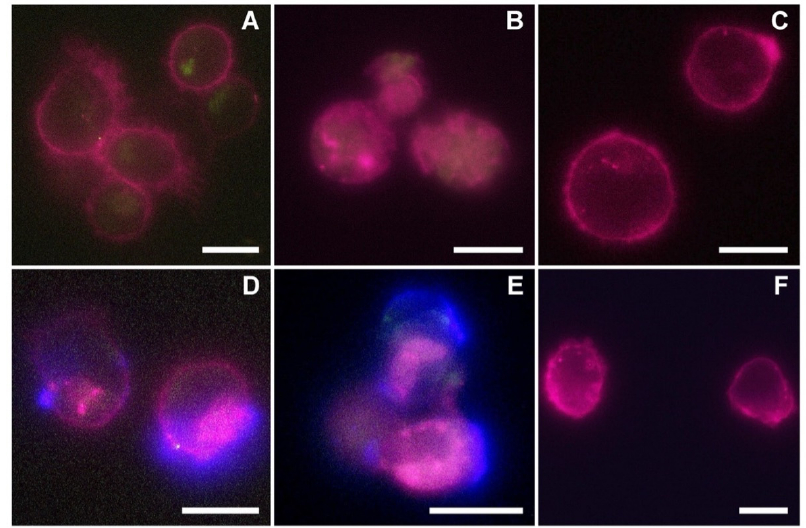
Figure 9. Representative fluorescence microscopy images of the three cell lines incubated for 48 h with 5 µg/mL of native (top panels) and anti-CD20 engineered lymphocyte-derived EVs (bottom panels). Panels A and D refer to lymphocytes, B and E to Daudi, and C and F to HL60 cell lines incubated with nEVs ( A – C ) and EVsCD20 ( D – F ). The purple color represents the cells’ membrane labeled with WGA647, green refers to the EVs labeled in WGA488, while the blue channel refers to the AMCA fluorescent signal of the secondary antibody linked to the nanoconstruct. Scale bars: 10 µm.